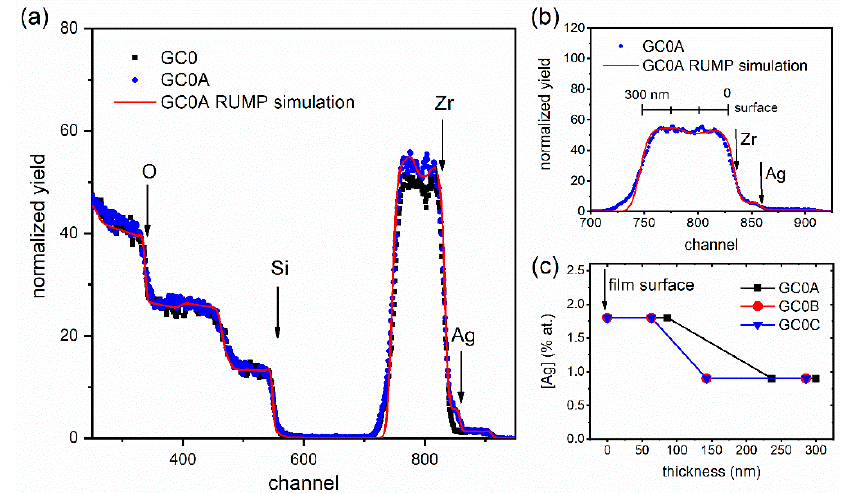
Figure 1. Full Rutherford backscattering spectrometry (RBS) spectra ( a ) and selected spectral region corresponding to Zr and Ag ( b ) for undoped samples before and after Ag-exchange (GC0 and GC0A). Ag concentration profile ( c ) as a function of film depth for samples GC0A, GC0B and GC0C. The RUMP code simulation of the GC0A spectrum is shown. In (b), the corresponding film depth is reported for the Zr signal.